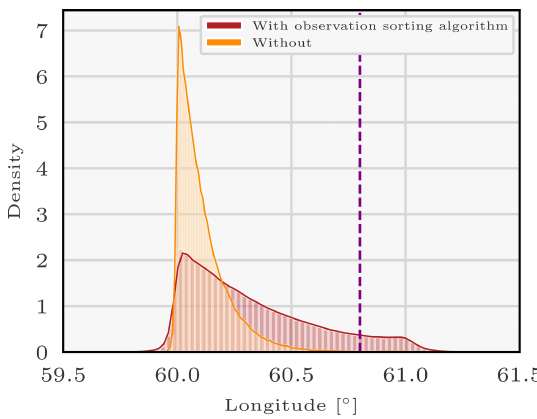
Figure 2. Density of the longitude for a log-Laplace likelihood with threshold 0 . 1mBqm − 3 of the 106 Ru source sampled with the 30 first members of the enhanced ensemble of observation operators using the parallel tempering method with or without the help of the observation-sorting algorithm. The purple vertical bar represents the longitude of the Mayak nuclear